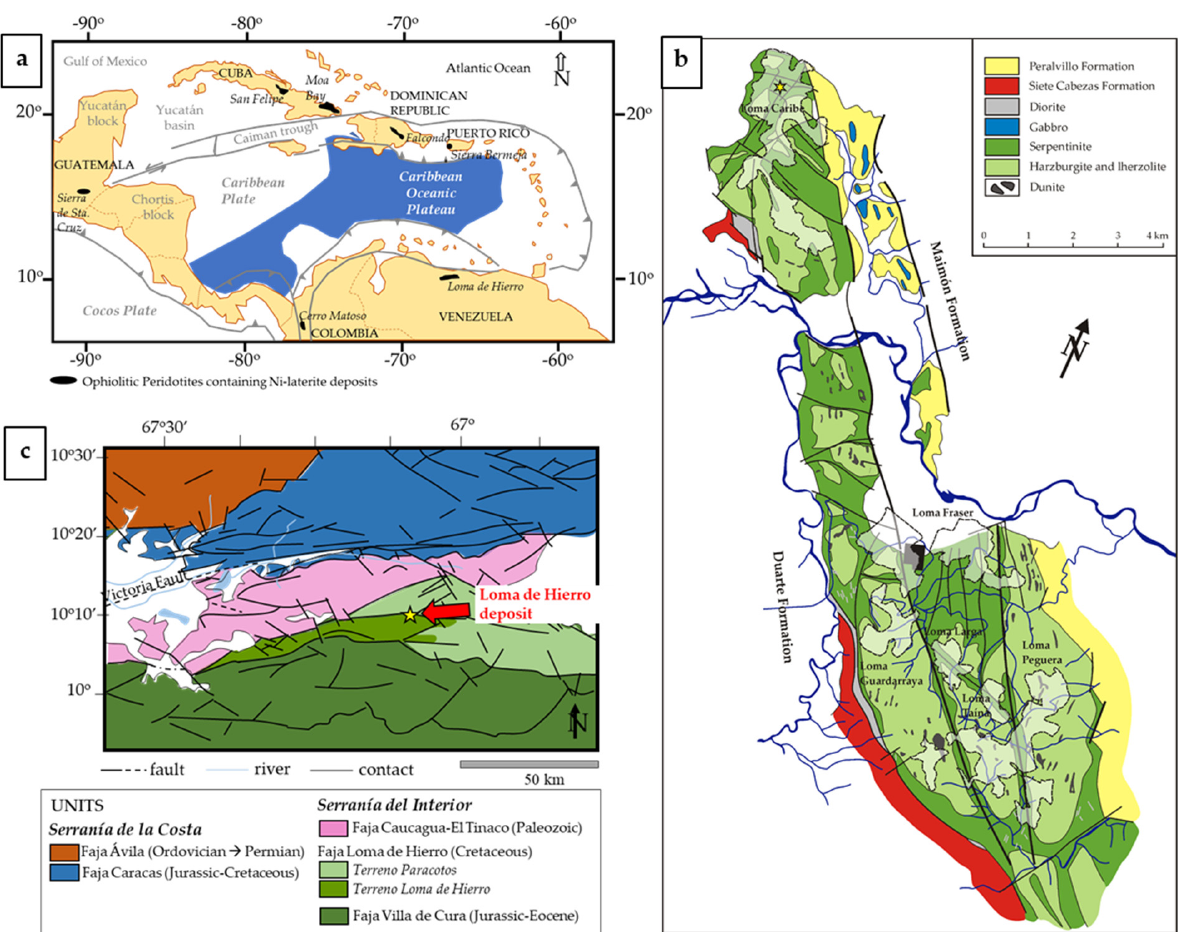
Figure 1. Loma Caribe (Dominican Republic) and Loma de Hierro (Venezuela) Ni laterite deposits: ( a ) location in the Caribbean region; ( b ) geological map of Loma Caribe (redrawn from [18]); and ( c ) geological map of Loma de Hierro (simplified from [20]).